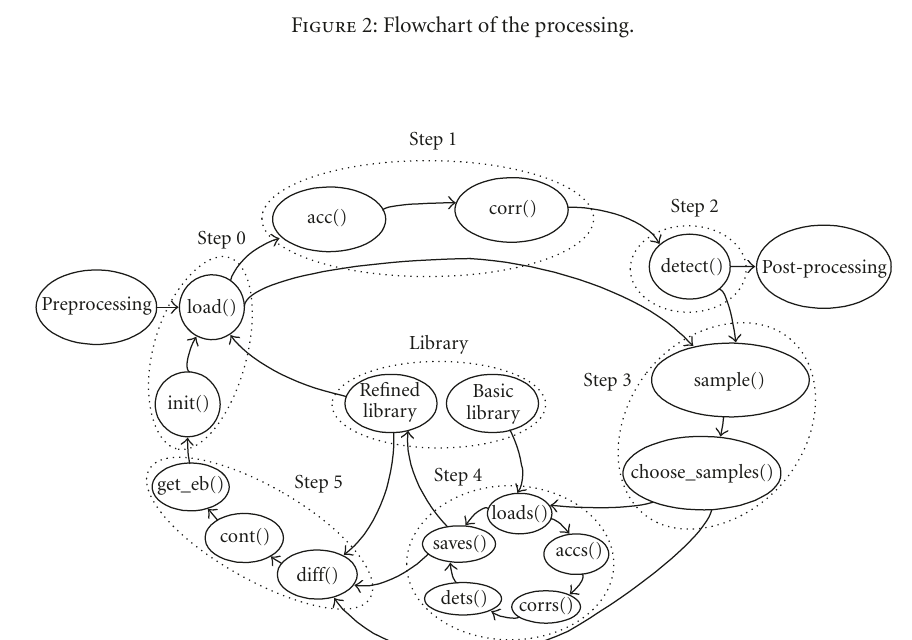
Figure 2: Flowchart of the processing.